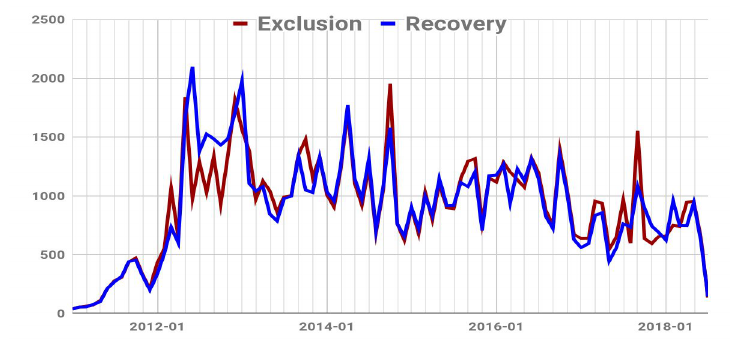
Fig. 1. ATLAS HammerCloud automatic exclusion and recovery actions. The plot shows number of automatic actions taken monthly by HammerCloud. The exclusion actions are triggered by functional test job failures, usually caused by an infrastructure issue. We aim to minimize exposure of ATLAS physicists to the infrastructure issues. Upon addressing the issue, when the tests start succeeding again, we automatically recover the resource, re-enabling the resource for physics analysis.